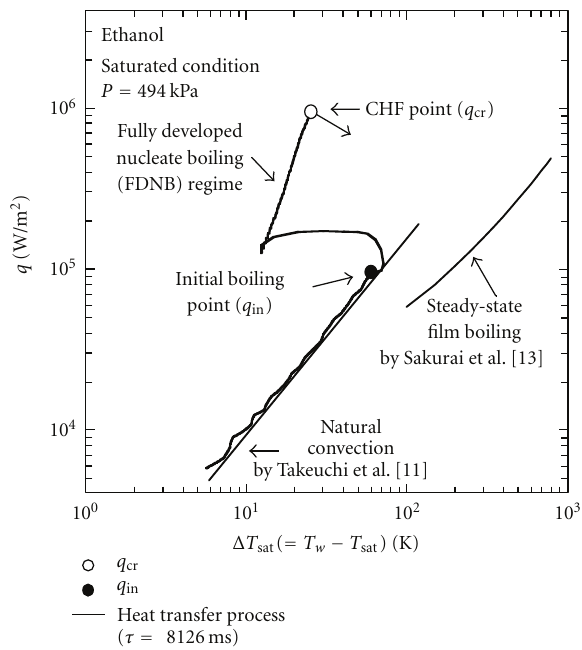
Figure 3: Boiling heat transfer process from non-boiling to fully developed nucleate boiling.